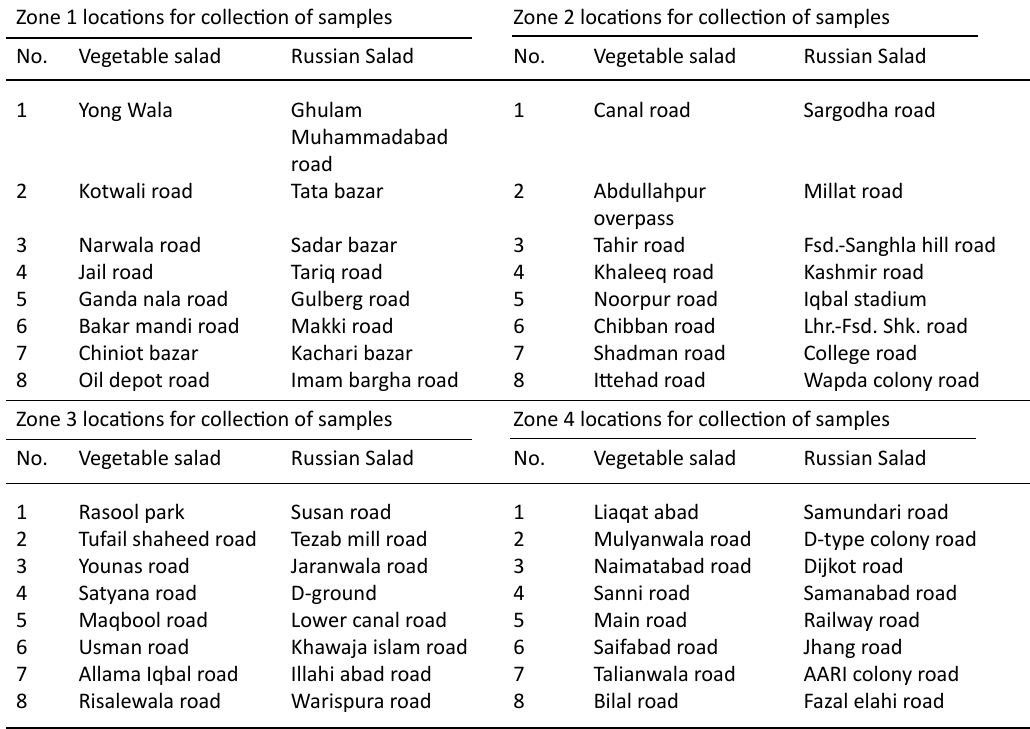
Table 1. Sampling plan for vegetable and Russian salads collection Zone 1 locations for collection of samples Zone 2 locations for collection of samples